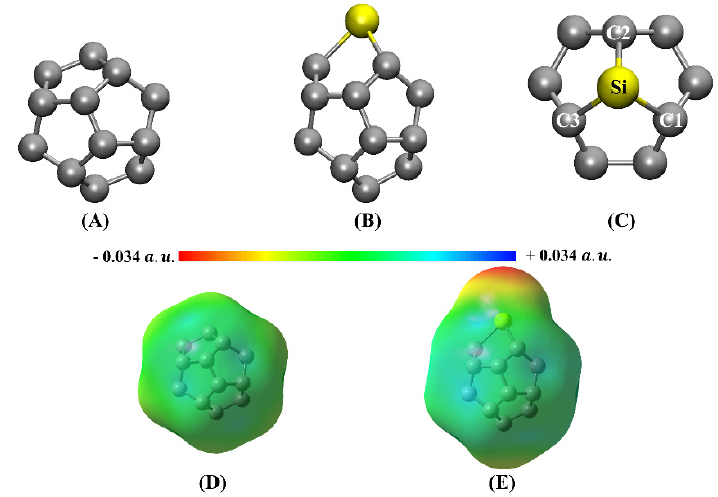
Figure 1. Optimized geometries of the ( A ) C 20 and ( B ) C 19 Si fullerenes as obtained at the ω B97XD/6- 311+G(d,p) level of theory. ( C ) brings an upper view perspective of the C 19 Si structure. Molecular Electrostatic Potential (MEP) map of ( D ) C 20 and ( E ) C 19 Si.